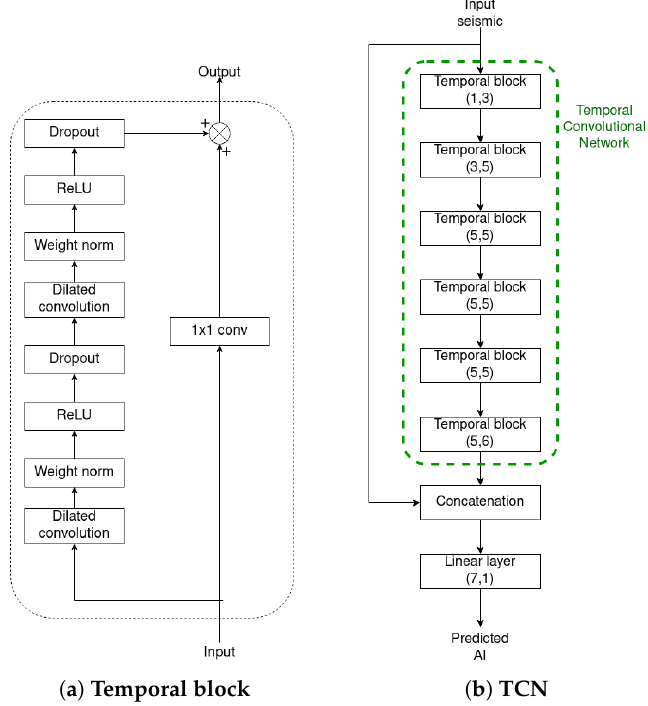
Figure 3. Architecture of a temporal block and the TCN. Source: adapted from